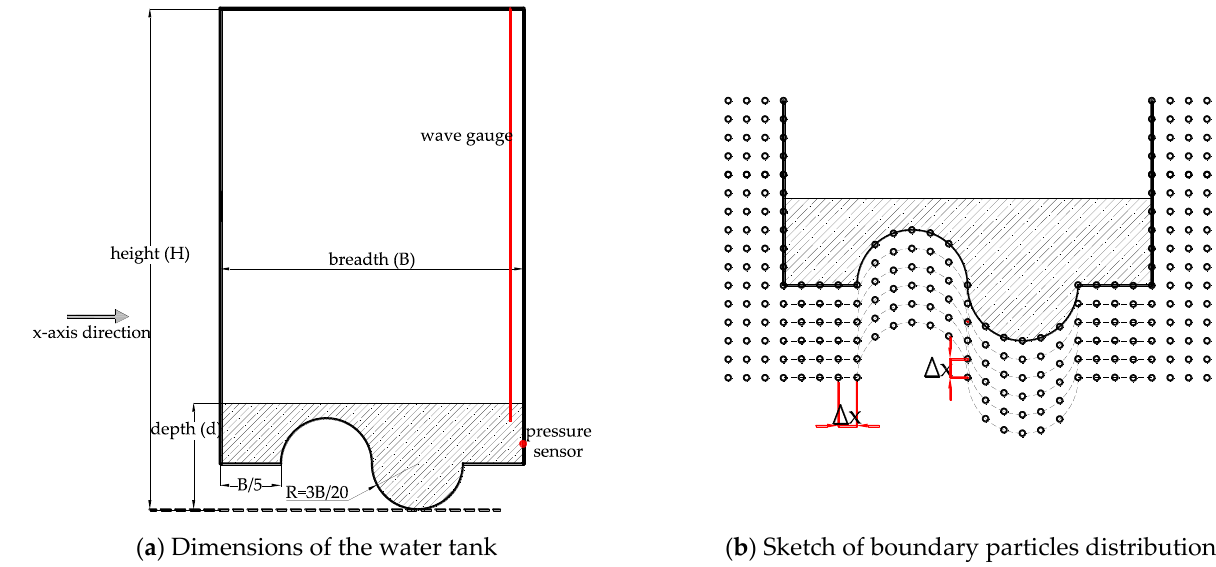
Figure 9. Configuration of the water tank: ( a ) Dimensions of the water tank; ( b ) Sketch of boundary particles distribution.